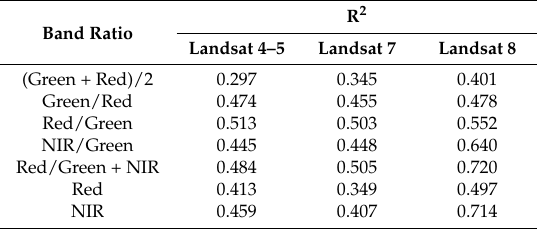
Table 3. Spectral band ratios for suspended sediment retrieval from multispectral satellite sensors. The R 2 value represents the linear correlation between the ratio and the measured SSC for each